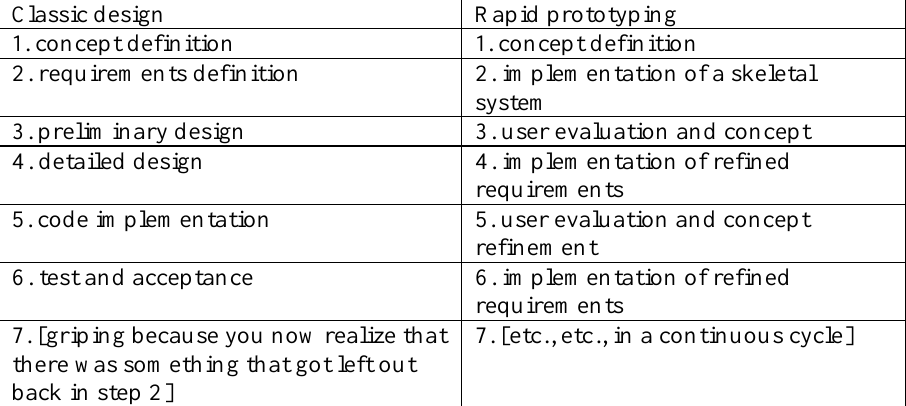
Classic Instruction Design and Rapid Prototyping Classic